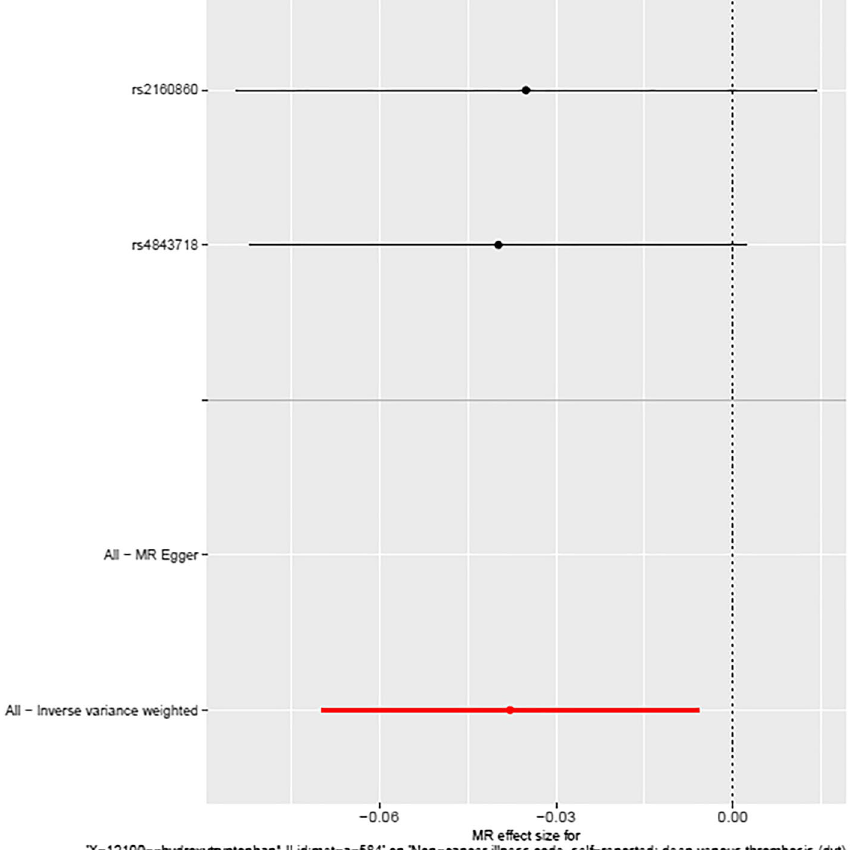
Figure 2. Forest Map of causality between Hydroxytryptophan-related SNP and DVT. The causal effect of exposure on outcome is estimated using each SNP singly using the Wald ratio, and represented in a forest plot. The MR estimate using all SNPs using the MR Egger and IVW methods are also